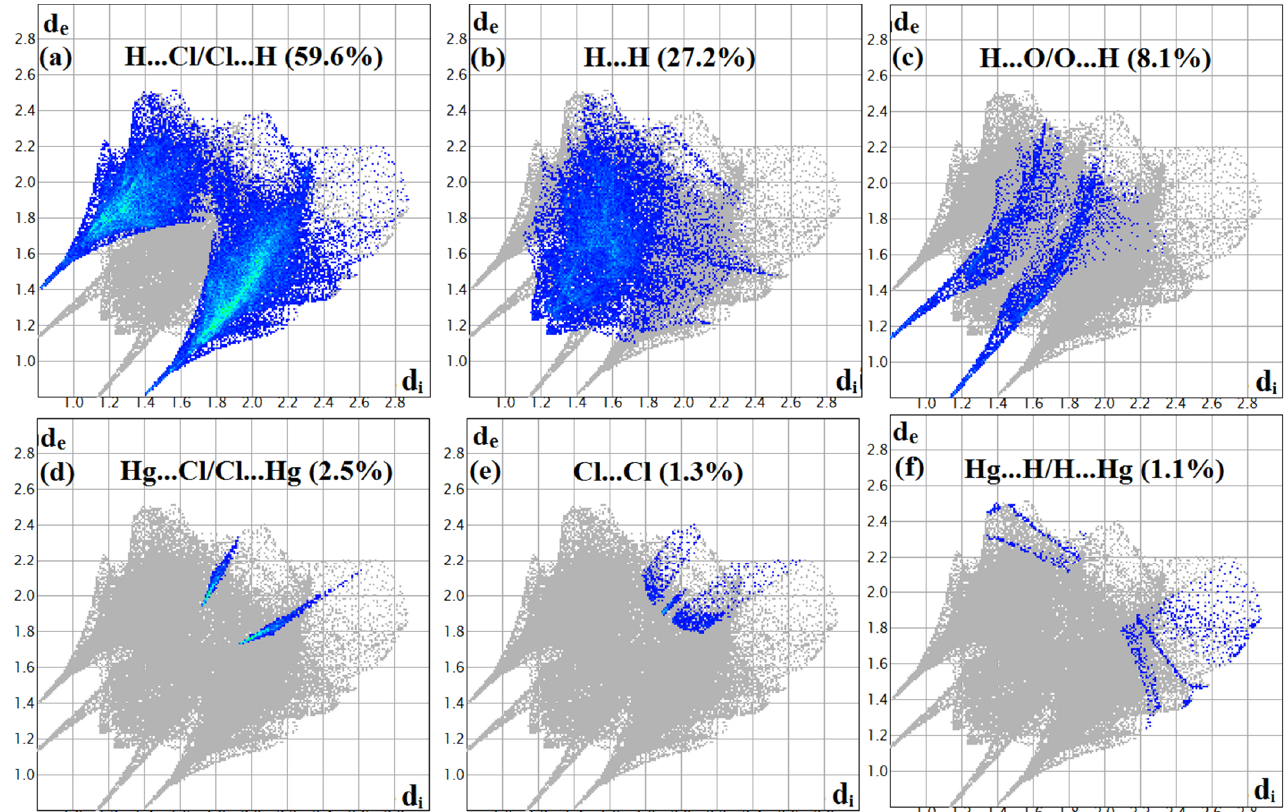
Figure 7. Relative contributions of various intermolecular interactions to the Hirshfeld surface area of (C 5 H 14 N 2 )[HgCl 4 ] · H 2 O: ( a ) H . . . Cl/Cl . . . H contacts; ( b ) H . . . H contacts; ( c ) H . . . O/O . . . H contacts; ( d ) Hg . . . Cl/Cl . . . Hg contacts; ( e ) Cl . . . Cl contacts; ( f ) Hg . . . H/H . . . Hg contacts. Table 2. E XY (enrichment reports) of (C 5 H 14 N 2 )[HgCl 4 ]·H 2 O.